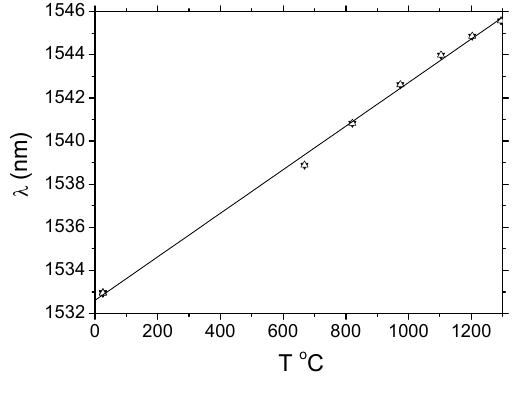
Figure 3. Bragg wavelength shift as a function of temperature cycling (room temperature to 1295 o C). Two cycles are shown with no evidence of distortion arising from material